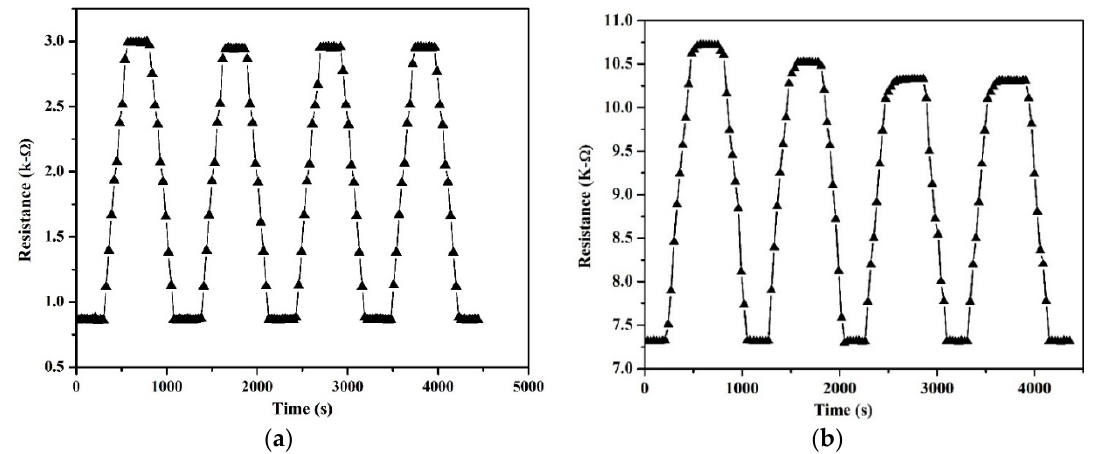
Figure 7. Repeatability of ( a ) suspended carbon nanotubes, and ( b ) non-suspended carbon nanotubes.